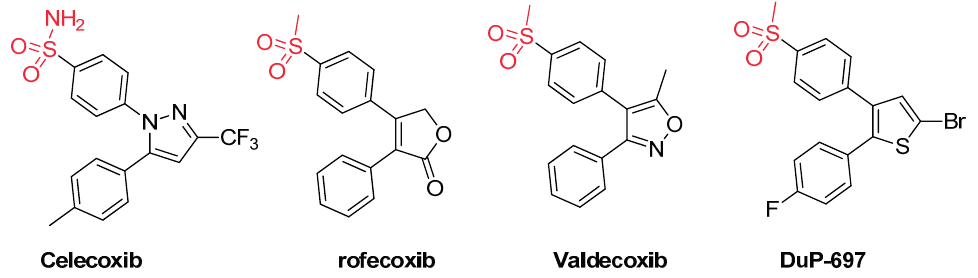
Figure 2. Chemical structures of some selective COX-2 inhibitors